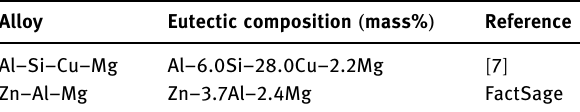
Table 1: Eutectic compositions of Al – Si – Cu – Mg and Zn – Al – Mg